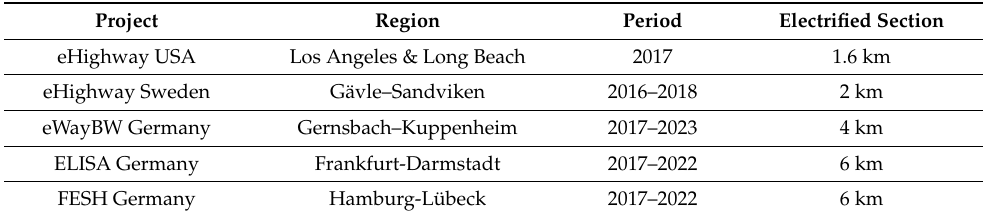
Table 6. Catenary vehicle projects